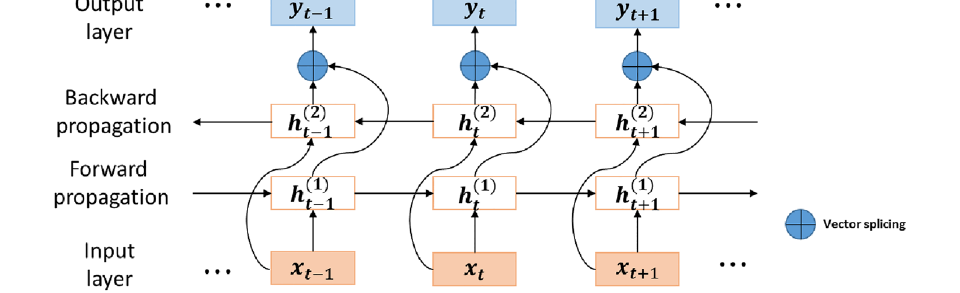
Figure 7. The structure of